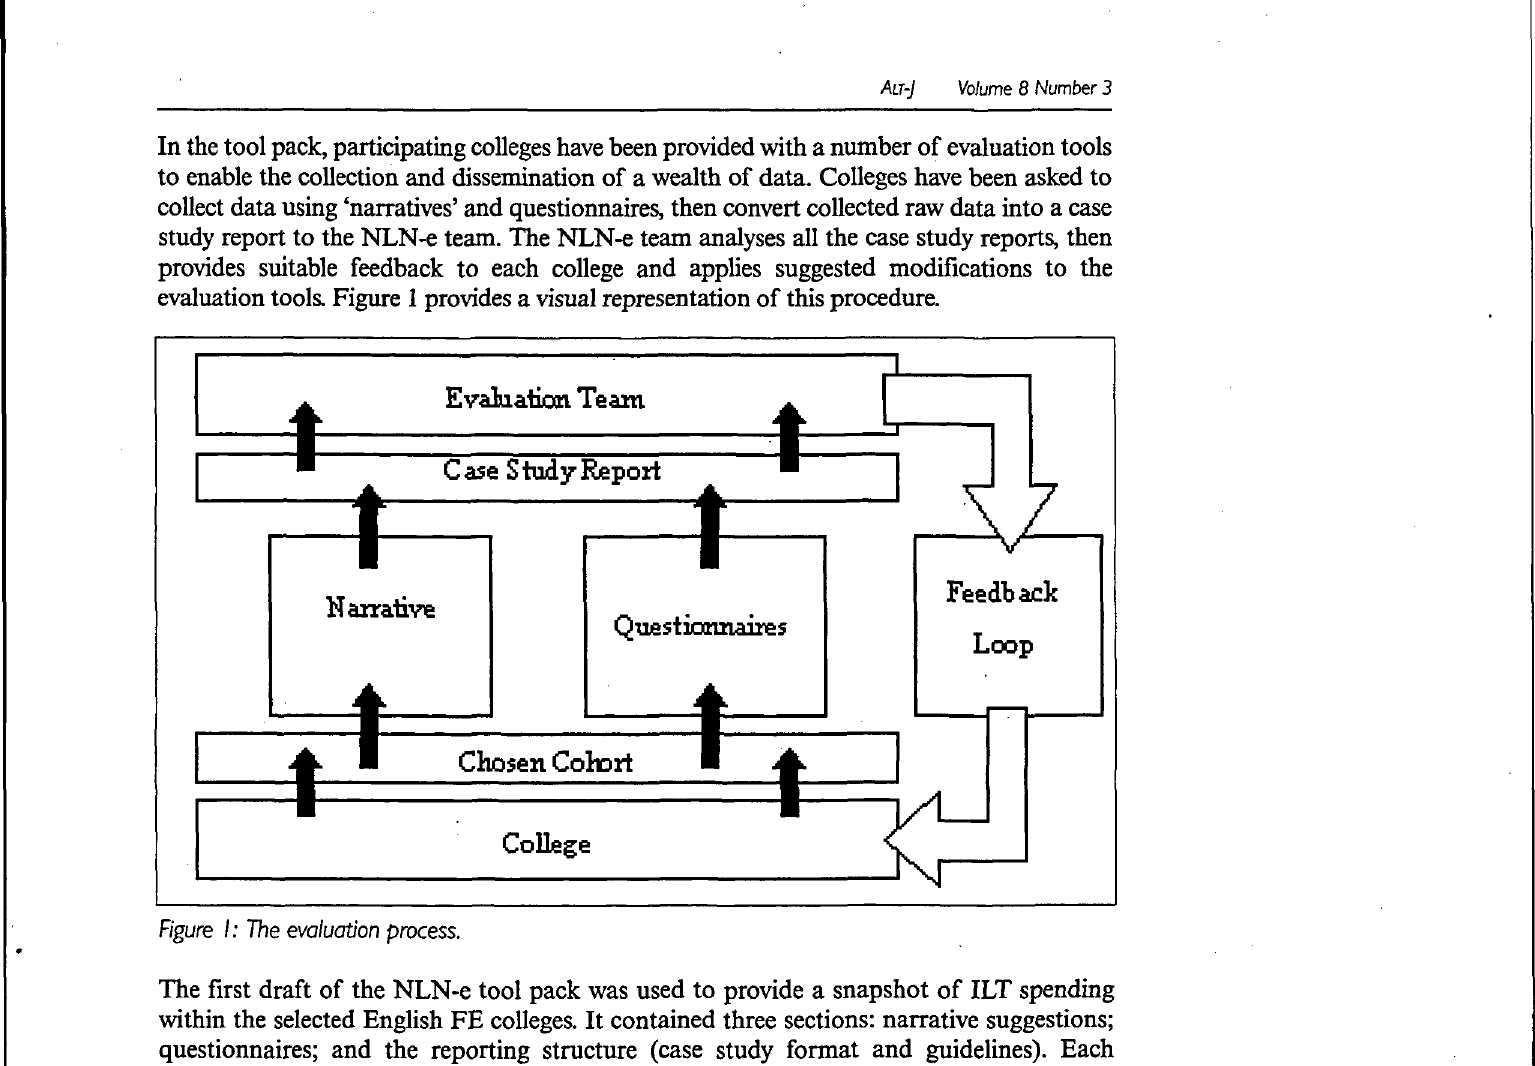
Figure I: The evaluation